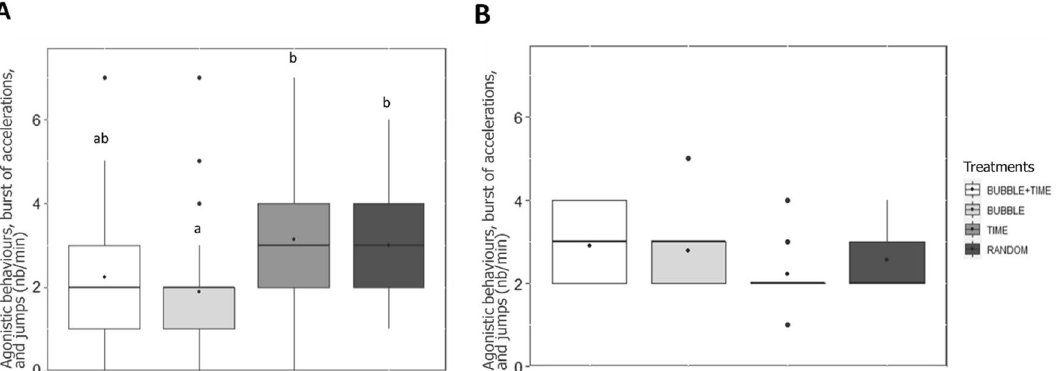
Figure 6. Median (quartiles: 25%, 75%) number of agonistic behaviours, burst of accelerations, and jumps scored per minute during ( A ) the 6-min period following each of the three feed omission occasions, when pooled, and ( B ) three neutral periods of 6 min free from feedings or bubbles on day 12. The black point inside boxes represents the mean value. Different letters indicate significant differences between treatments ( P < 0.05; Tukey post-hoc